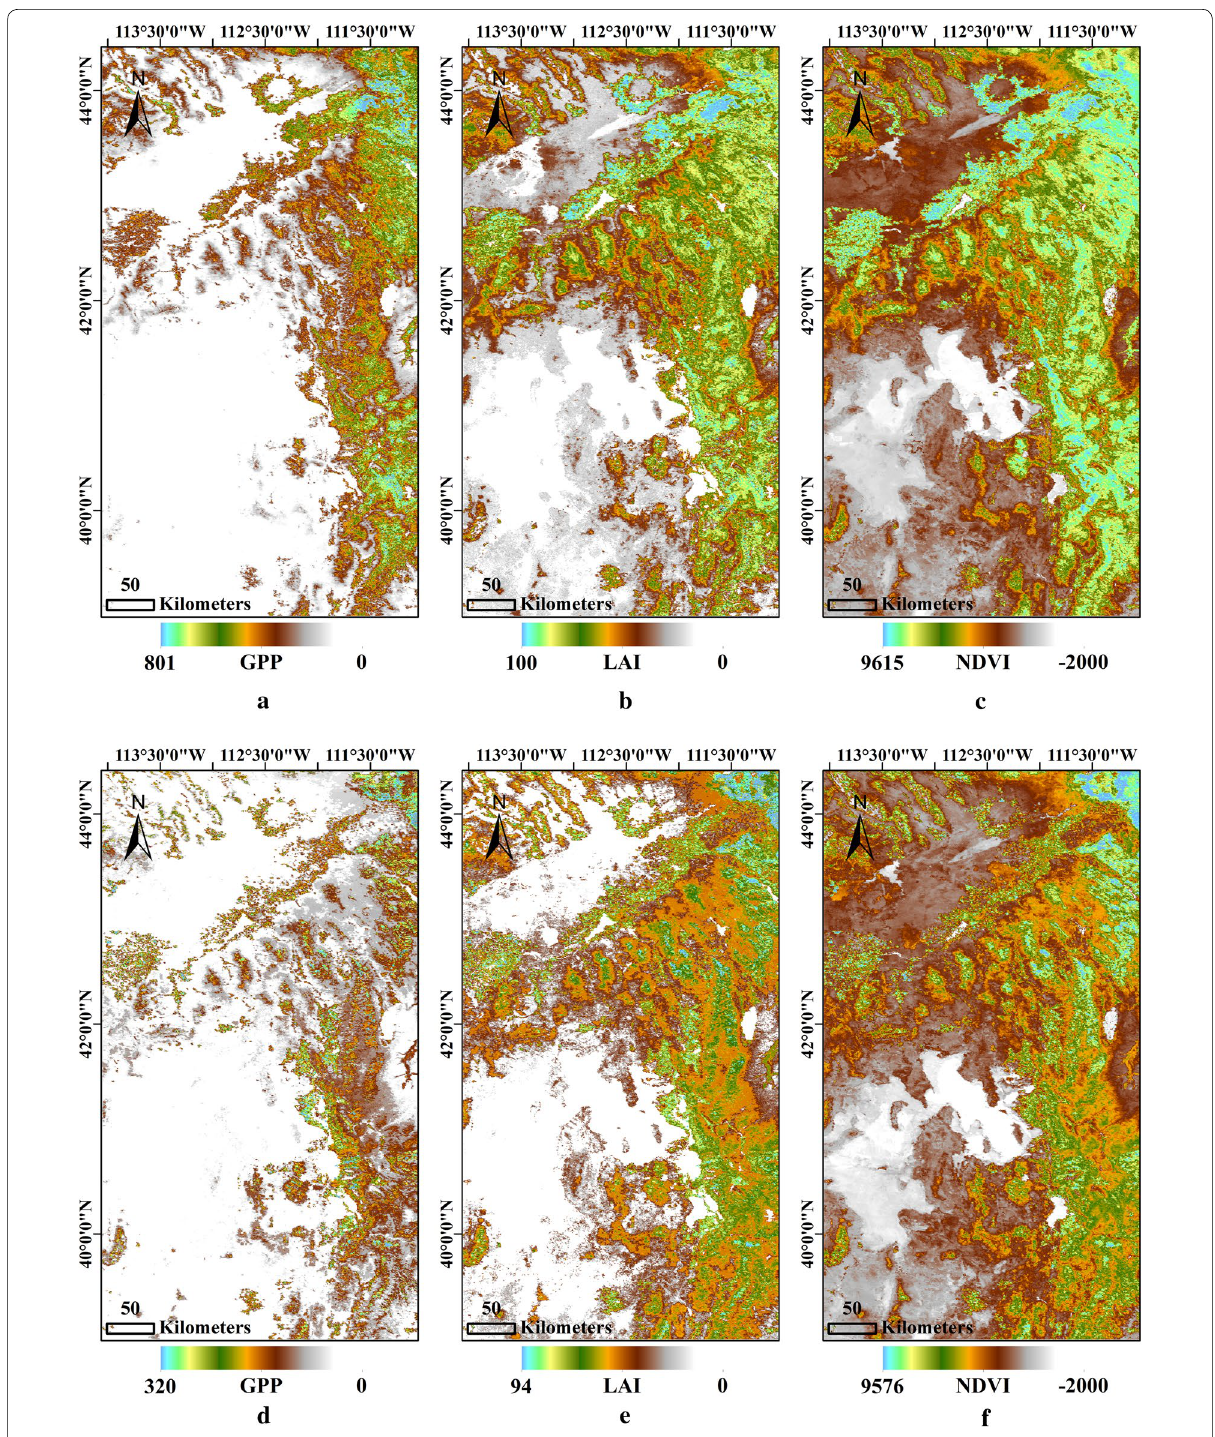
Fig. 11 Vegetation index products: a 2010-07-28 GPP; b 2010-07-28 LAI.; c 2010-07-28 NDVI; d 2010-10-16 GPP; e 2010-10-16 LAI; f 2010-10-16